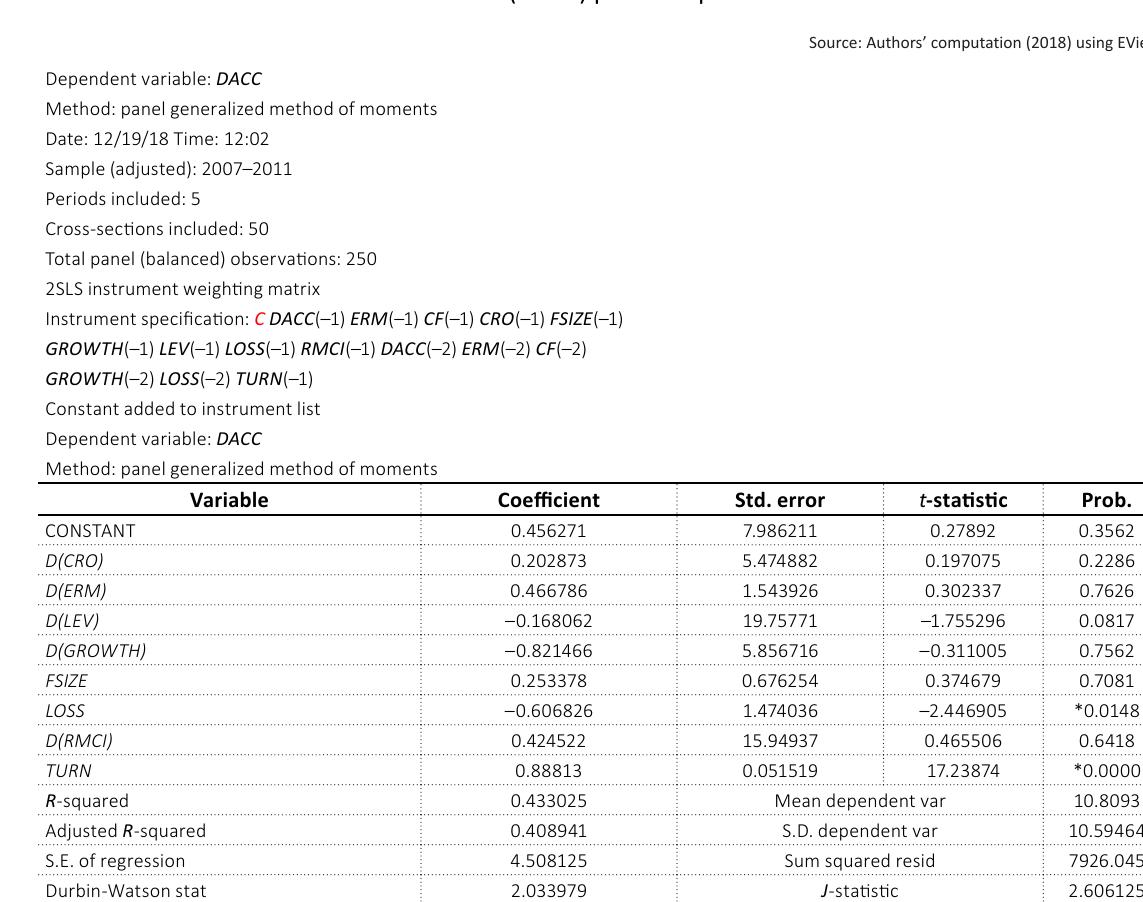
Table 4. Generalized method of moments (GMM) pre-ERM